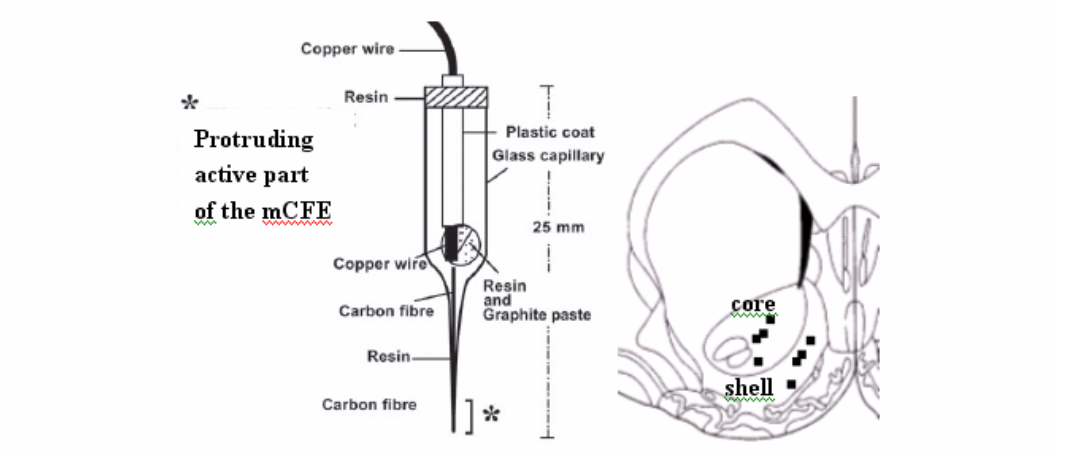
Figure 1. LEFT: schematic representation of the carbon fibre microelectrode used in the present experiments. RIGHT: Example of locations of the amperometric recording sites in core and shell indicated by the black squares drawn onto a representative section of the rat brain: coordinates accordingly to Paxinos and Watson [34], see Experimental